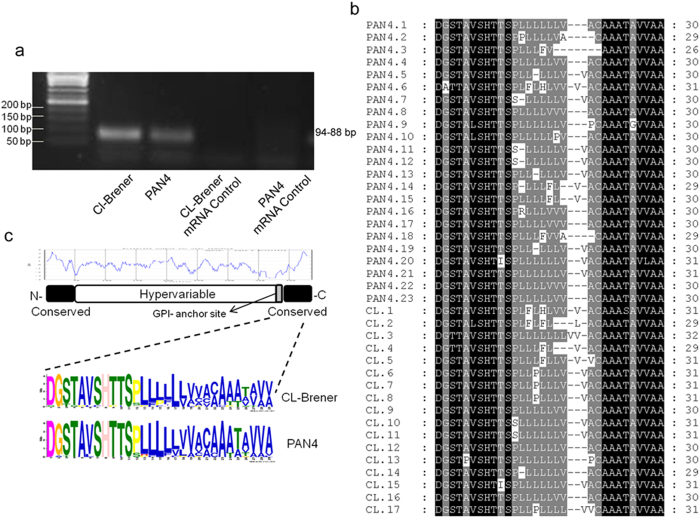
Analysis of the expressed MASP C-terminal amino-acid sequences.(a) Agarose gel (2%) of the amplicons of the MASP C-terminal region (94-88 bp) using cDNA from the CL-Brener and PAN4 strains as a sample and including an mRNA quality control for both strains. (b) Multiple alignment of the sequences obtained from the C-terminal region expressed in the PAN4 (23 clones) and CL-Brener (17 clones) strains. Residues showing 100% conservation are in black and those showing >80% are in grey. (c) The graph (blue lines) represents a Kyte-Doolitle hydrophaty plot of a prototypical MASP sequence schematized below it. The amino-acid frequencies of the C-terminal end of the MASPs expressed by both strains were elucidated by MEME (see material and methods) and are represented at the bottom.